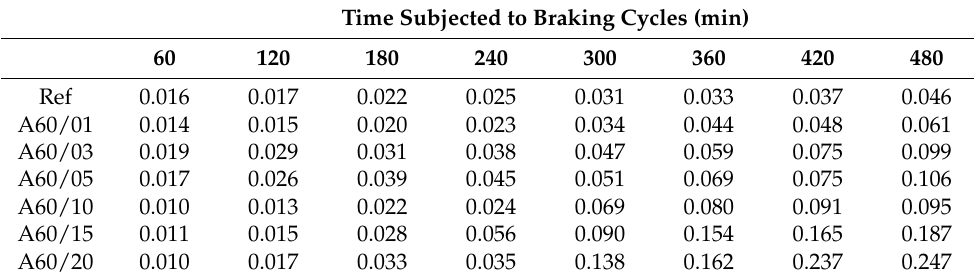
Table 5. Weight loss (g) of brake pads with different rubber